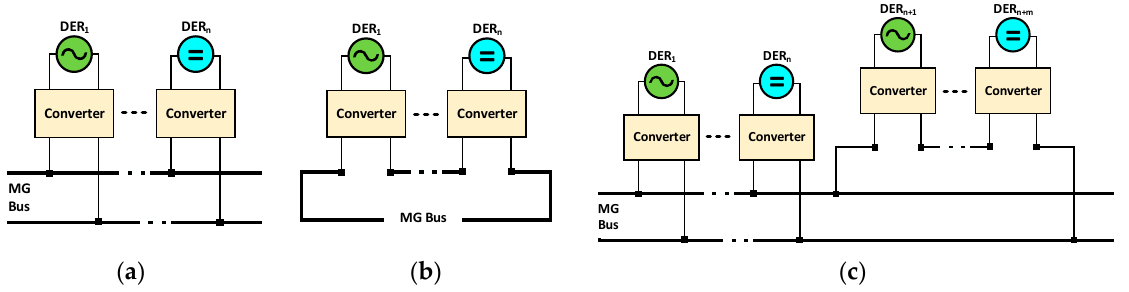
Figure 4. Simple diagrams of different MG structures in terms of DERs connection types: ( a ) Parallel structure; ( b ) Cascaded structure; ( c ) Hybrid parallel–cascaded structure.